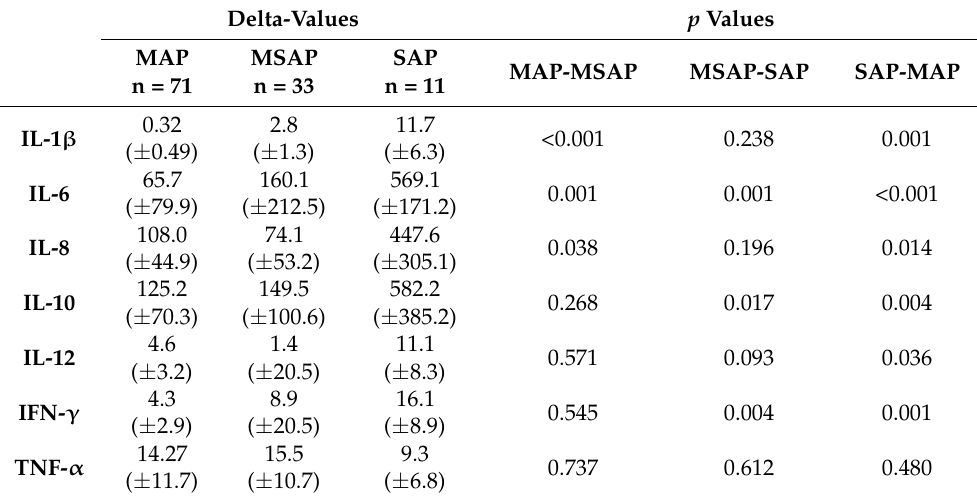
Table 4. Delta-values and statistical differences between severity